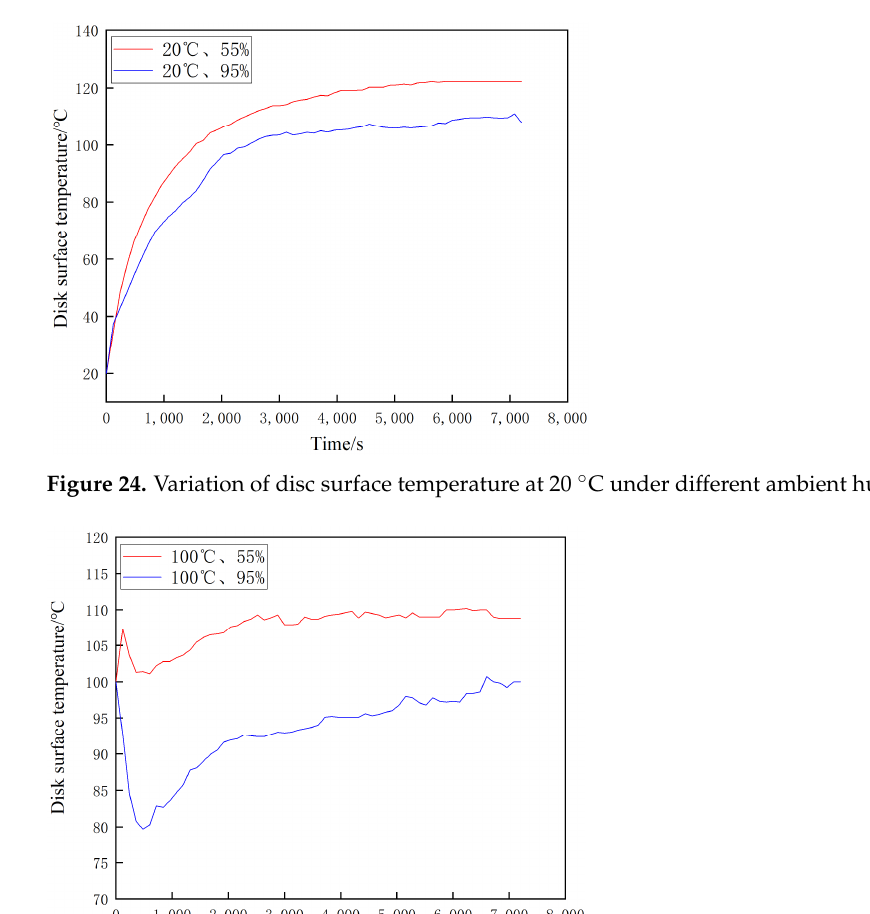
Figure 25. Variation of disc surface temperature at 100 °C under different ambient humidities.